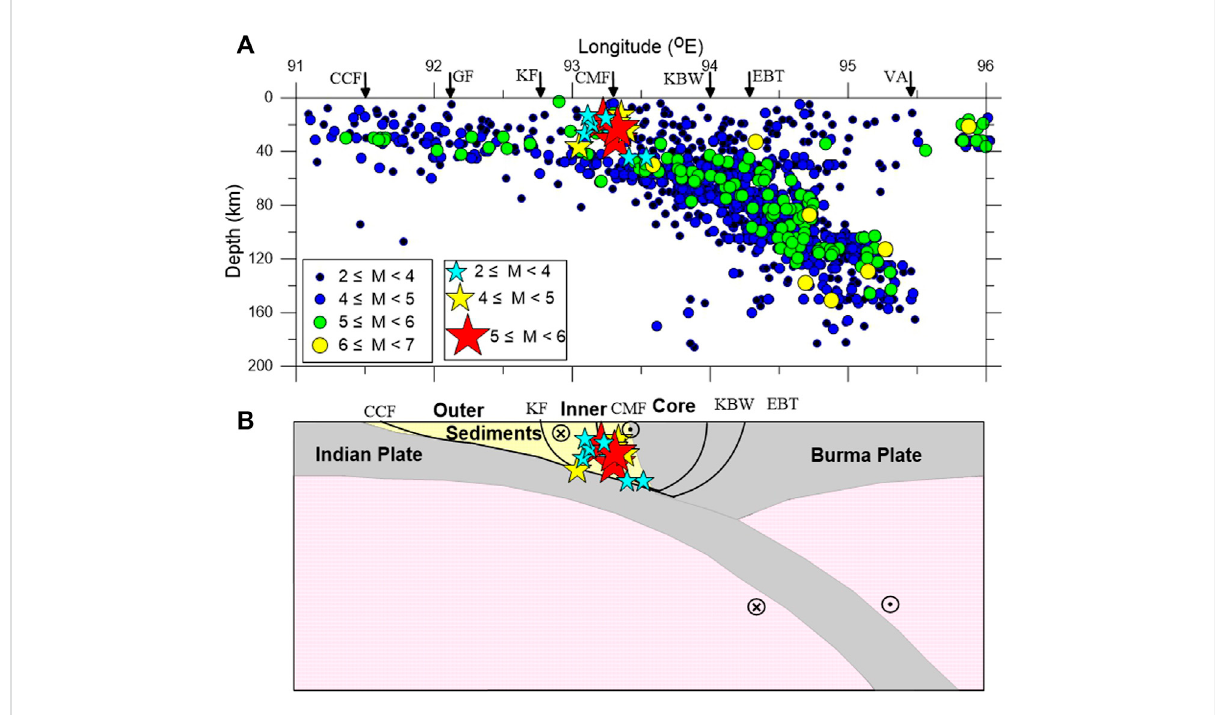
FIGURE 2 (A) Depth distribution of events along a pro fi le coinciding with 23 o Latitude is shown in the fi gure. The events surrounding the pro fi les are collectedandplottedwithdifferentmagnitudescalesandlabelled.TheeventsthatoccurredduringJune — August2020arealsooverlappedoverthe map and are shown by star symbols. Important tectonic elements crossing the pro fi les are projected over the map and are also labelled. The labels used in the fi gure are followed from Figure 1. (B) A tectonic model of the region is shown and overlapped by events that occurred from June to August 2020 in the study area.